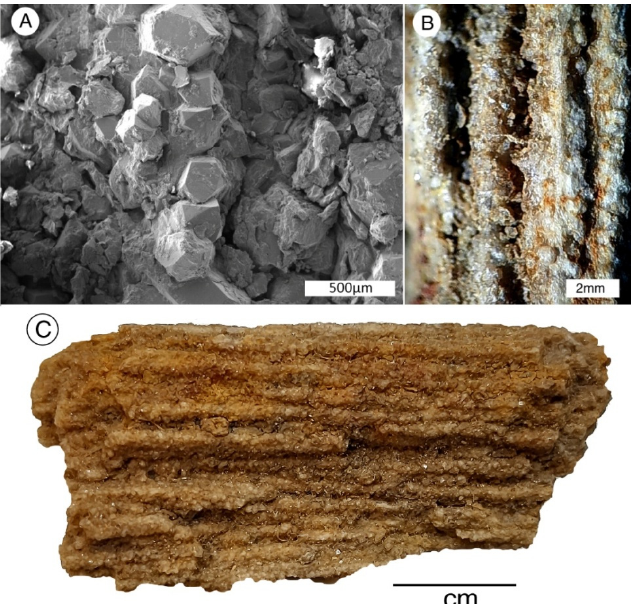
Figure 8. Quartz-mineralized wood from Tak log BT-6.Cells are coated with quartz crystals, but incomplete mineralization is evidenced by partially open intercellular spaces. ( A ) SEM image of subhedral quartz crystals coating individual cells, longitudinal orientation. ( B ). Low magnification optical microscope photo showing open intercellular spaces between crystal-coated cells. ( C ) Quartz crystals coating wood fibers are large enough to be seen with the unaided eye. Geosciences 2022 , 12 , x FOR PEER REVIEW